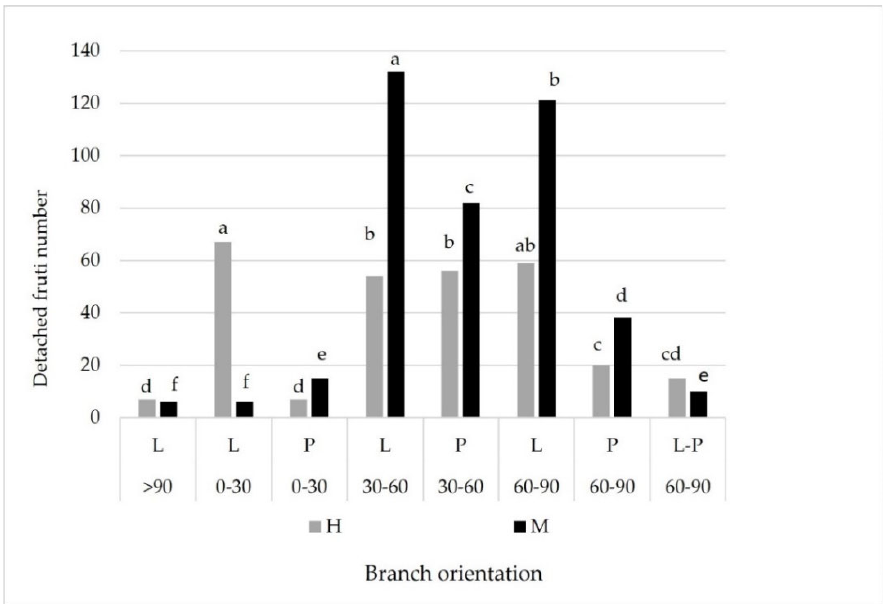
Figure 4. Total number of fruits mechanically (M) and manually (H) detached in different length classes (0–30, 30–60, 60–90, ≥ 90 cm) and orientation of branches: longitudinal (L) and perpendicular (P). Means followed by the same letter do not differ significantly at p ≤ 0.05 according to Duncan’s test. Statistical comparisons were carried out within each thinning technique.